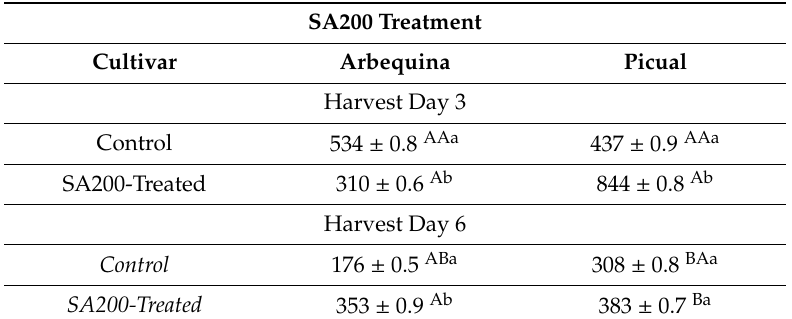
Data are presented as means of three independent samples. Di ff erent superscript bold upper-case letters in the same row between cultivars within the control samples and the same harvest day indicate di ff erences at p < 0.05. Di ff erent superscript normal upper-case letters in the same column between harvest days 3 and 6 within the same type of sample (control and treated) and same cultivar indicate di ff erences at p < 0.05. Di ff erent superscript lower-case letters in the same column between control and treated samples within the same harvest day and same cultivar indicate di ff erences at p < 0.05. Table 3. Hydroxytyrosol contents (expressed as mg kg − 1 weight ± SD) in olive fruits from olive trees ( Olea europaea L.) treated with 200 mg mL − 1 of salicylic acid (i.e., SA200). Data from olive samples picked on days 3 and 6 after SA200 application and from two varieties (Arbequina and Picual) are included.